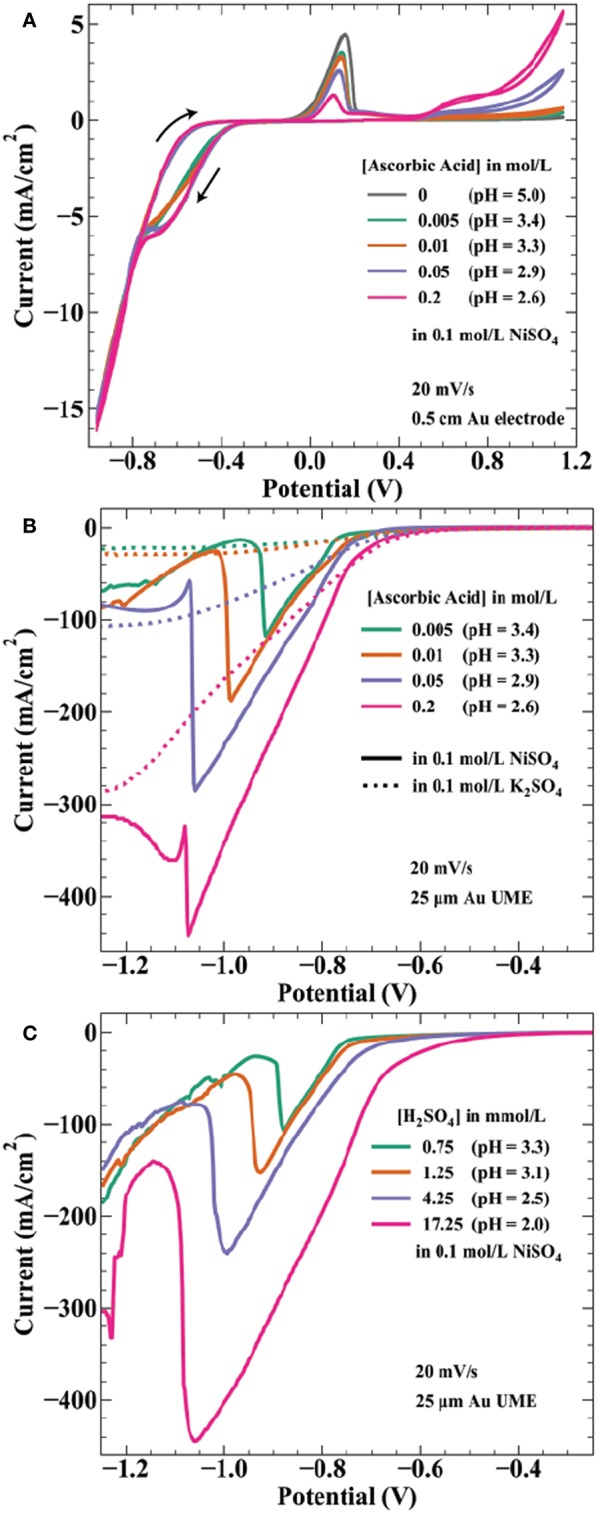
Voltammetric measurements of nickel deposition in ascorbic acid and sulfuric acid containing electrolytes. (A) Cyclic voltammetry at 20 mV/s on a 0.5 cm diameter Au electrode in 0.1 mol/L NiSO4 and the indicated ascorbic acid concentrations. Voltammograms initiated at 0.24 V, swept negative to −0.96 V, positive to 1.14 V, ending at 0.24 V. Linear sweep voltammetry at 20 mV/s from 0.24 to −1.26 V on a 25 μm diameter Au microelectrode for (B) the indicated ascorbic acid concentrations in 0.1 mol/L NiSO4 () or 0.1 mol/L K2SO4 (….) and for (C) the indicated H2SO4 concentrations in 0.1 mol/L NiSO4. pH values are indicated for each solution.